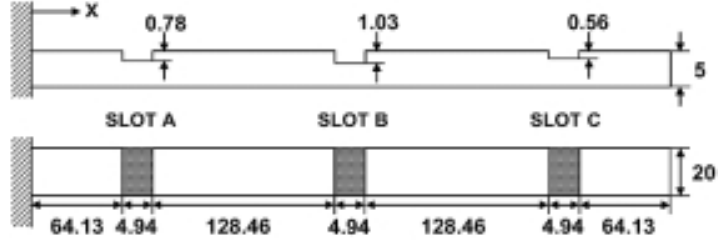
Fig. 6. Geometry of a damaged beam specimen (units: mm).